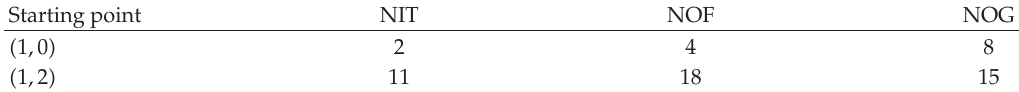
Table 2: Numerical results of Example 4.2.